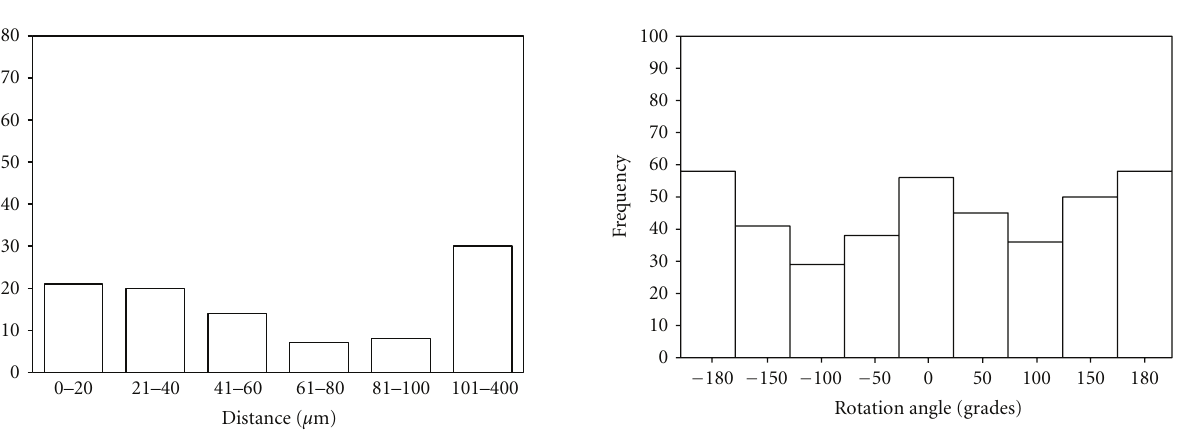
Figure 4: Quantitative motility analysis of free-swimming epimastig- otes . The analysis of motility traces of fluorescent epimastigotes showed that the average velocities of the parasites ranged from 1 μ m/10second to 400 μ m/10sec. The histograms show the range of distances that each cell traversed per 10 sec. For each parasite trajectory, 100 randomly chosen cells were analyzed.